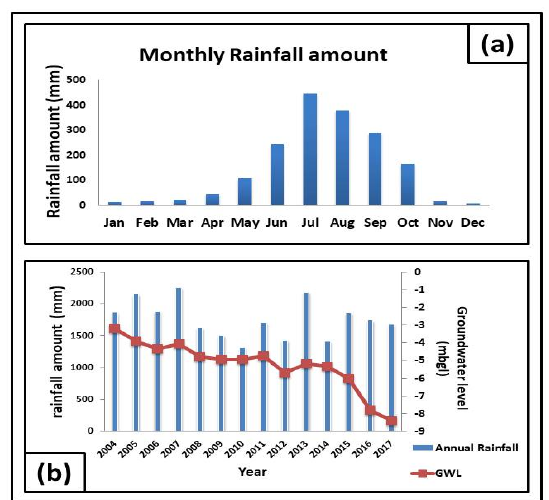
Figure 12. ( a ) Monthly rainfall amount in the study area, ( b ) Relationship between annual rainfall amount and changing groundwater level over the years (2004–2017) in the study